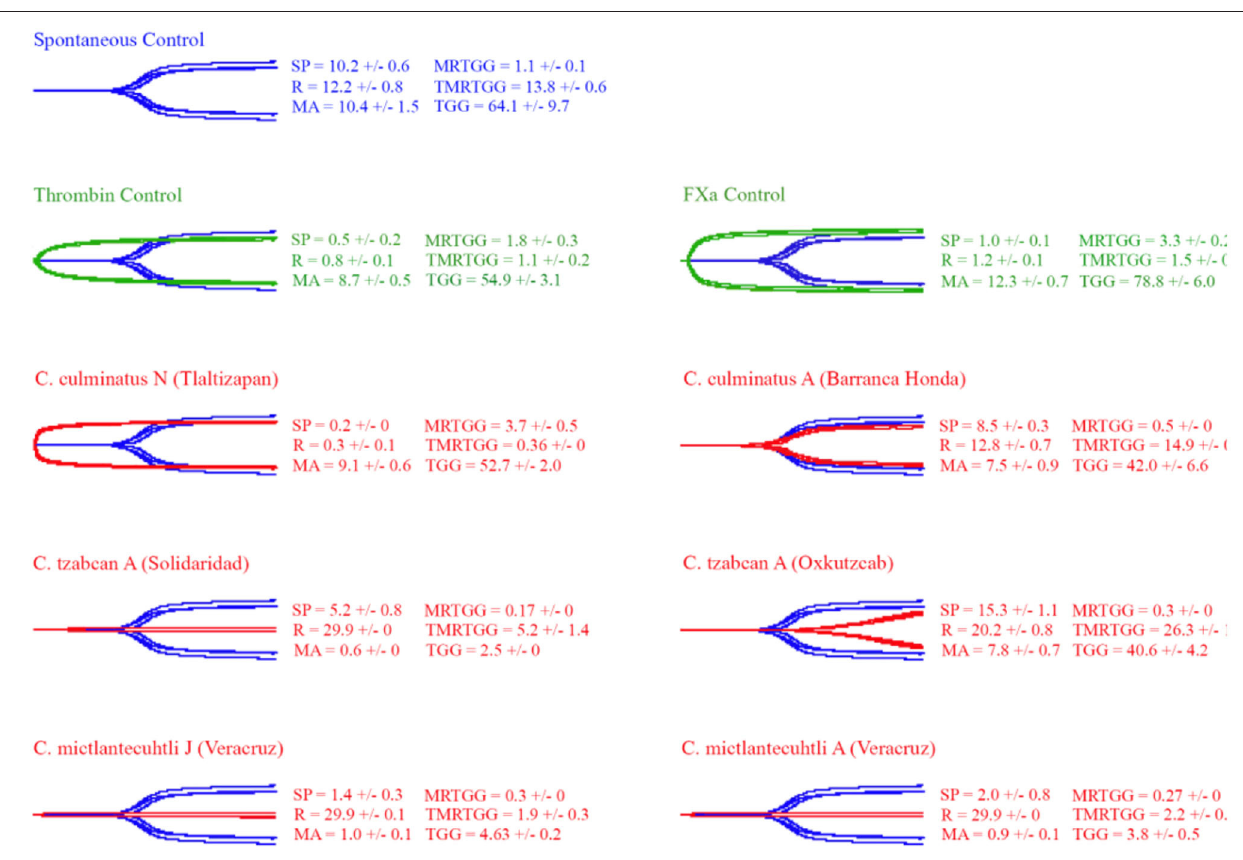
as best as possible to accurately characterize the venom